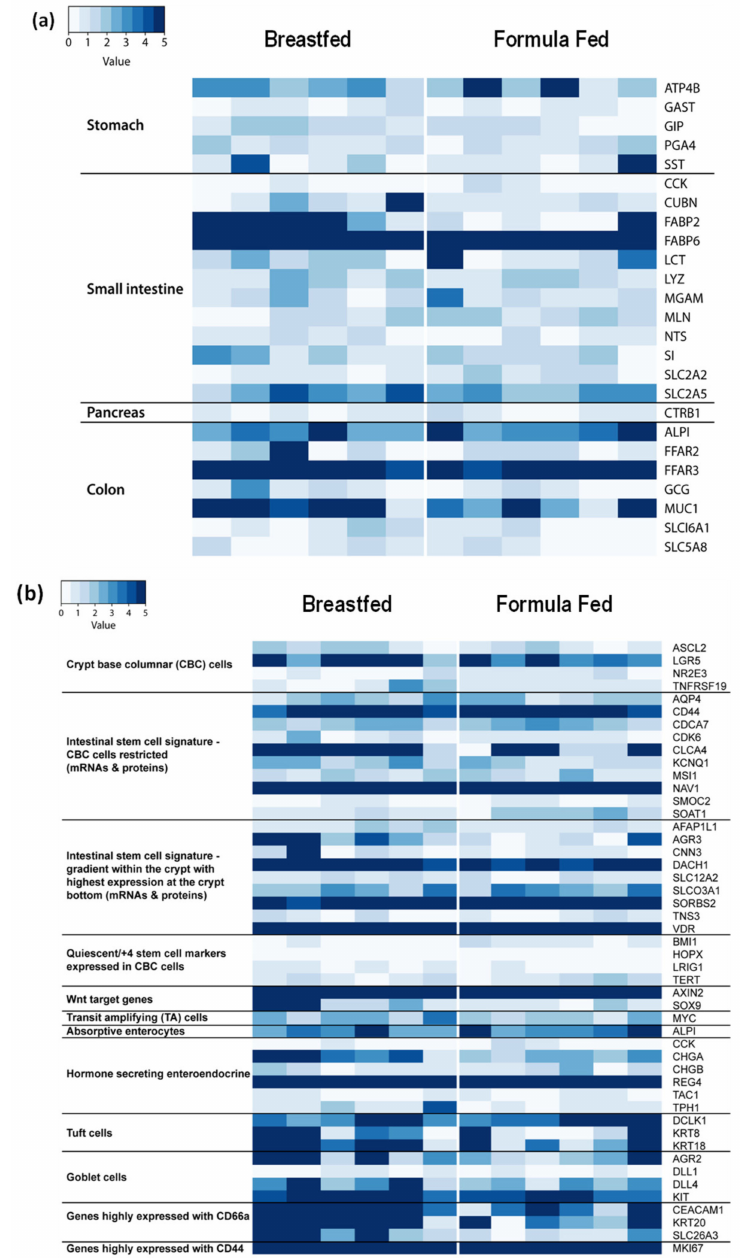
Figure 1. The exfoliome signatures related to anatomic locations and cell types. Heat map of the relative expression of genes expressed at specific anatomic locations (stomach, small intestine, pancreas, and colon) ( a ). Heat map of genes associated with specific cell types ( b ). Highly expressed genes are colored in dark